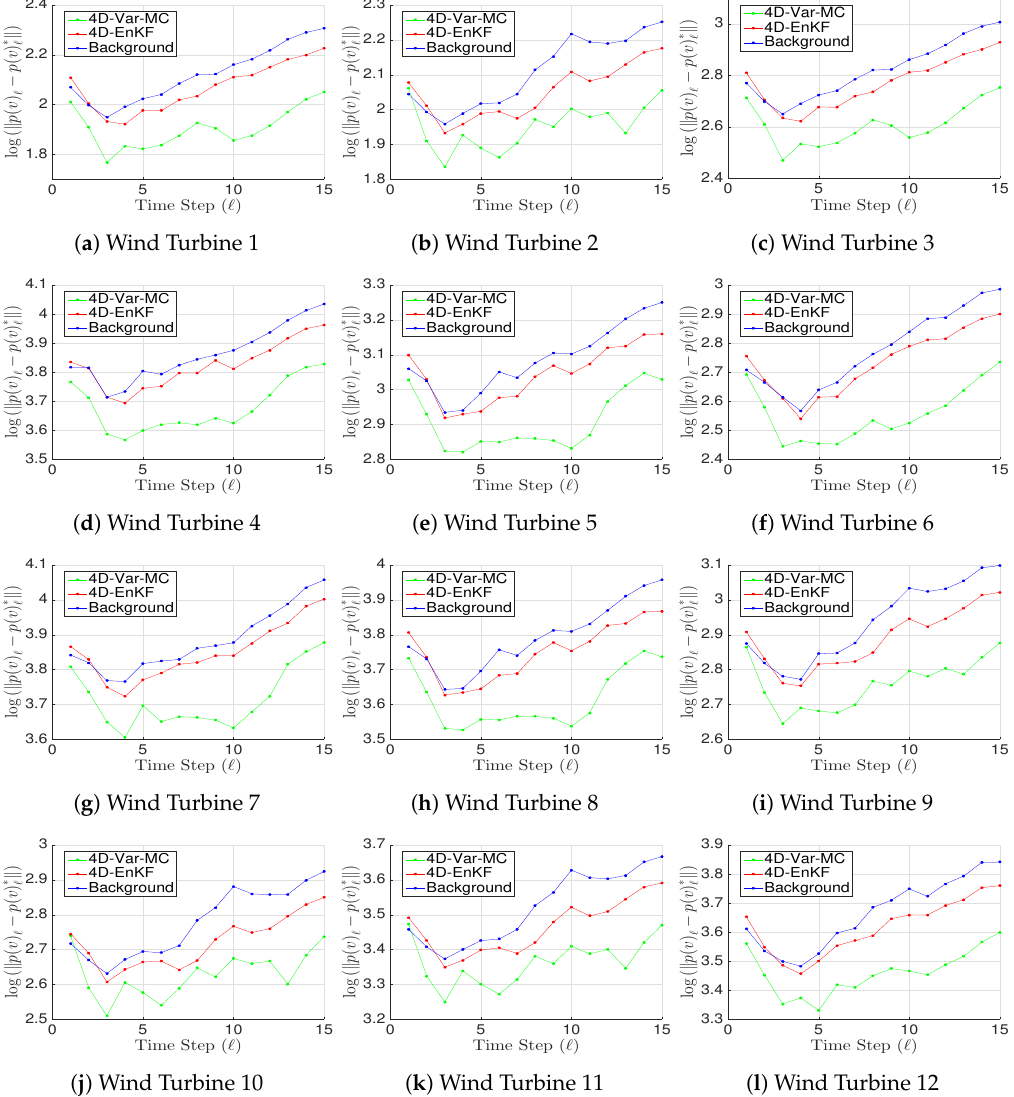
Figure 3. Error norms of wind energy potential estimations for the compared filter implementations. The ensemble size reads N = 20. 12 wind turbines are employed for the experiments. Units are in MW. ( a ) Wind Turbine 1; ( b ) Wind Turbine 2; ( c ) Wind Turbine 3; ( d ) Wind Turbine 4; ( e ) Wind Turbine 5; ( f ) Wind Turbine 6; ( g ) Wind Turbine 7; ( h ) Wind Turbine 8; ( i ) Wind Turbine 9; ( j ) Wind Turbine 10; ( k ) Wind Turbine 11; ( l ) Wind Turbine